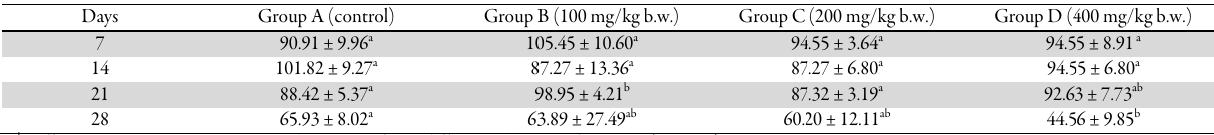
Different superscripts across a row indicates significant differences between the means (P < 0.05) Table 7. Mean serum urea (g/dl) levels (means ± standard error) of rat groups administered methanol fruit extract of Days